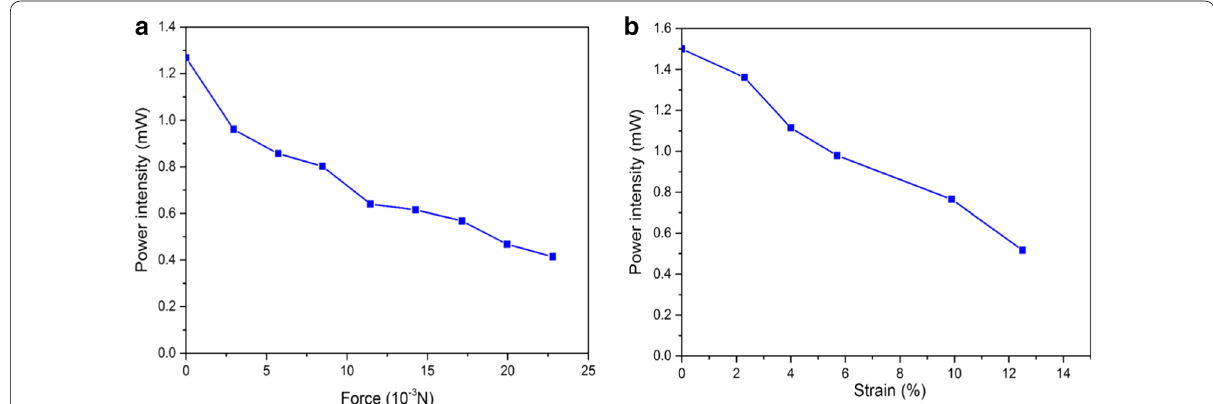
Fig. 7 The flexible and stretchable optical waveguide sensing experiments: a pressure vs. light intensity loss response graph, b strain vs. light intensity loss response